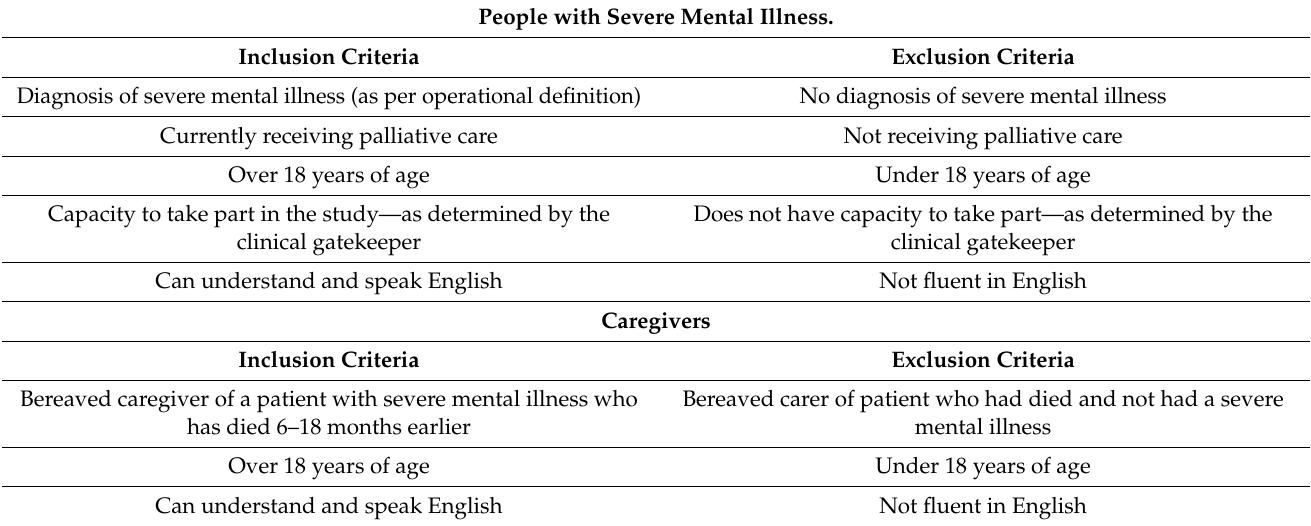
Table 1. Inclusion and exclusion criteria for Phase 3